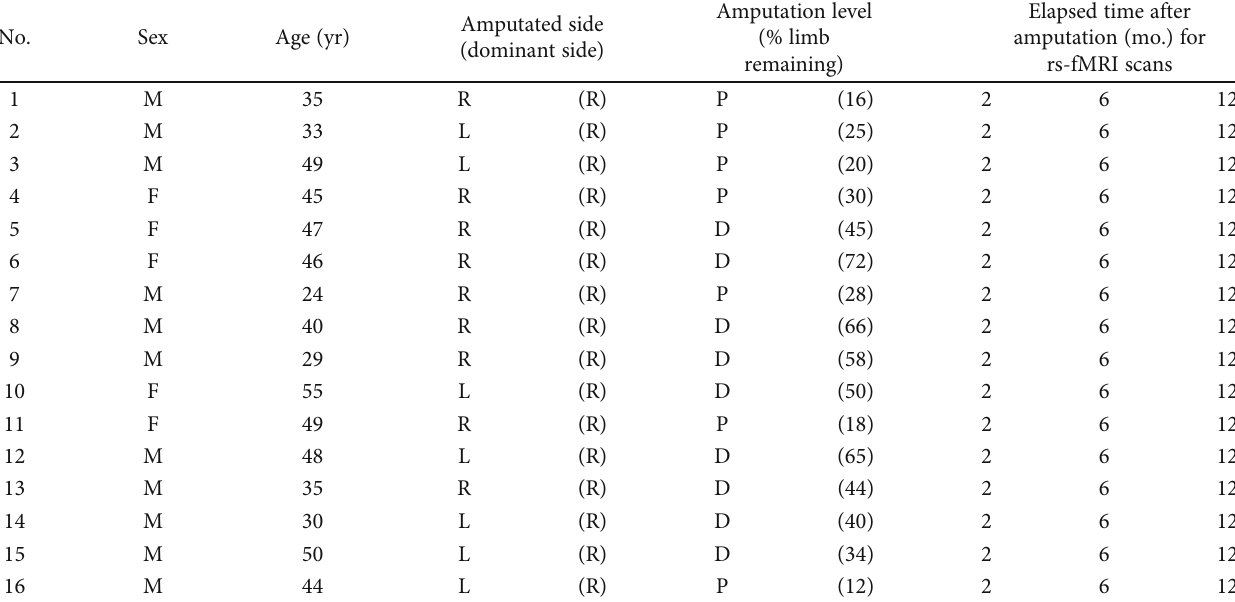
Table 1: Demographic and clinical characteristics of patients with upper-limb amputation ( n = 16